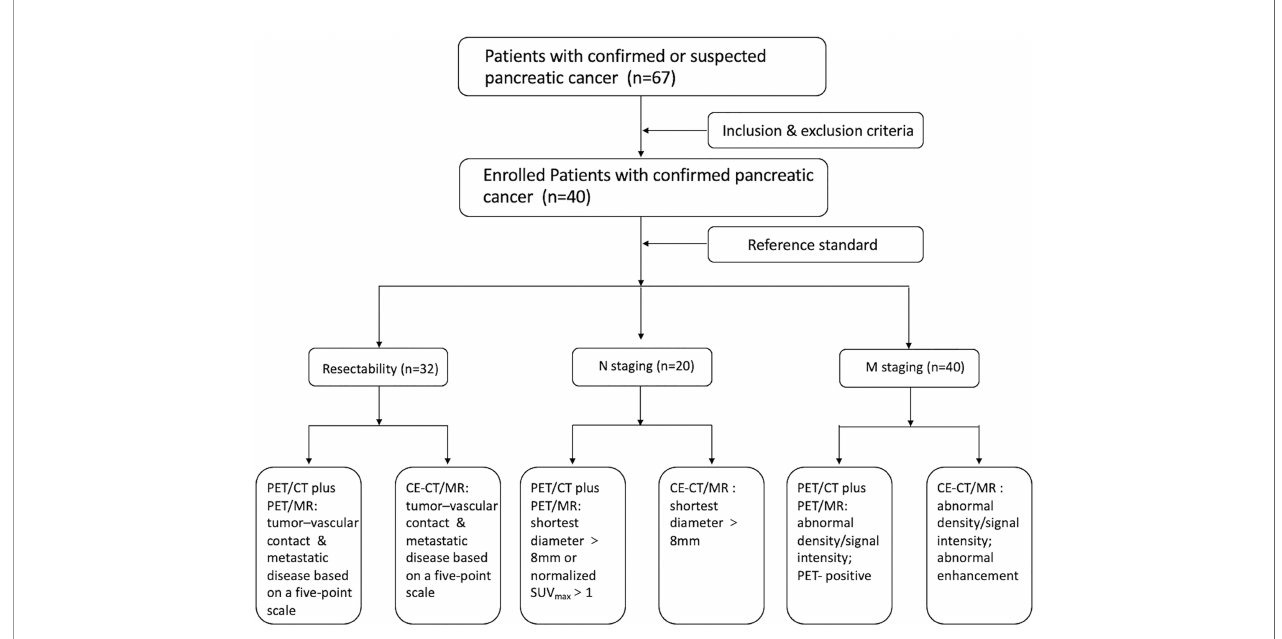
FIGURE 1 | The fl ow chart of the